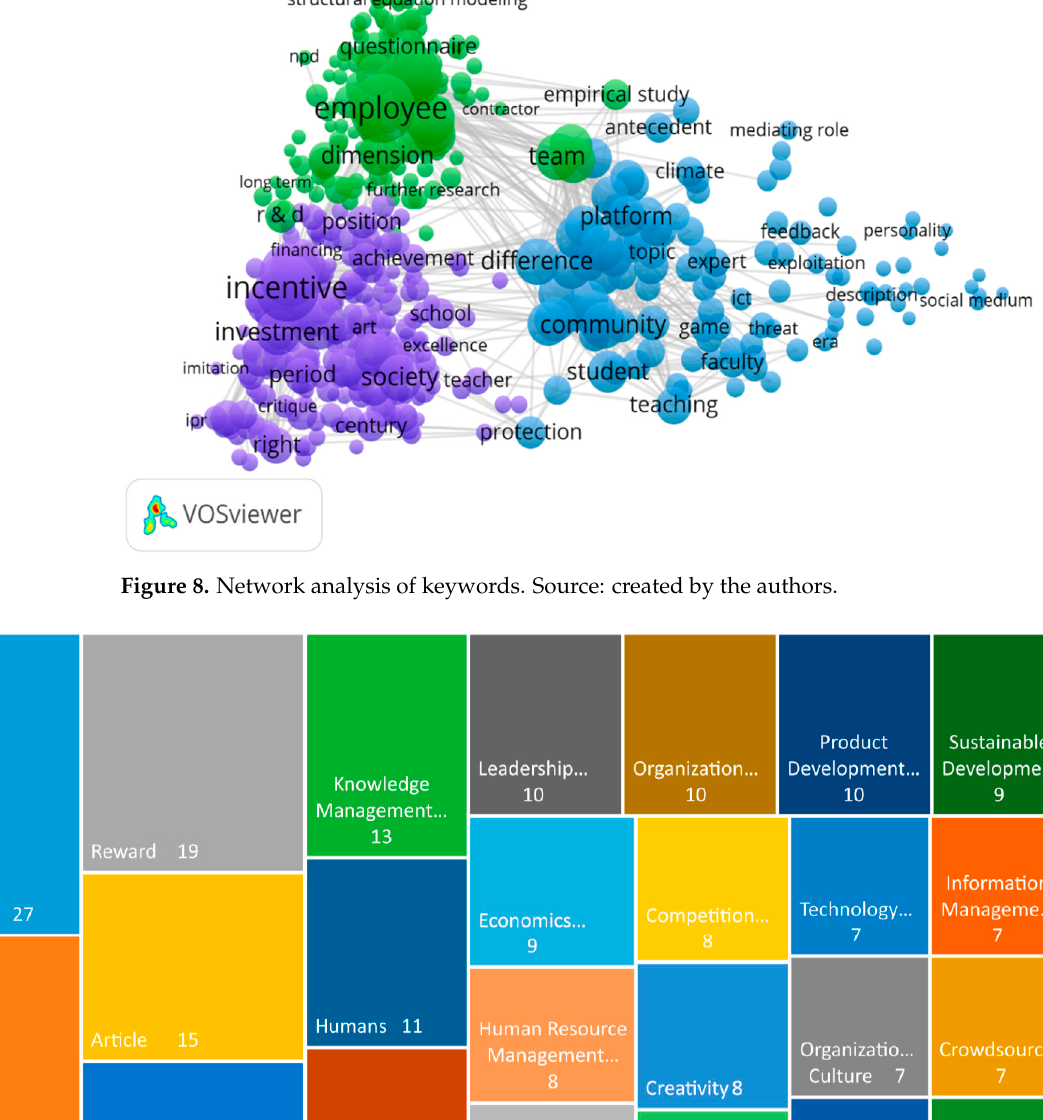
Figure 8. Network analysis of keywords. Source: created by the authors.